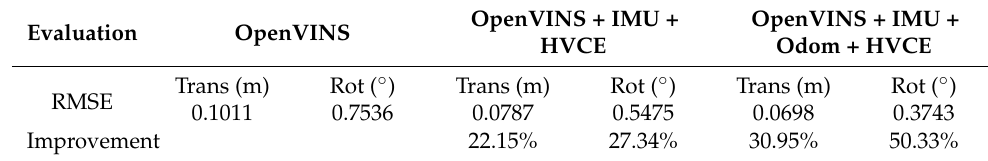
Table 2. The Root Mean Square Error (RMSE) results of OpenVINS and the proposed algorithm.